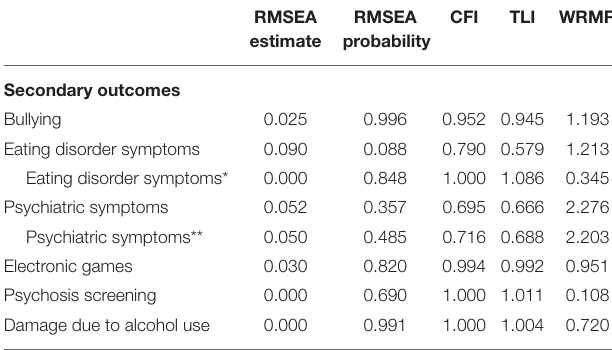
TABLE 3 | Internal agreement level according to the Kappa index for the primary outcomes of drug use by public-school students from the city of São Paulo paired in the segments 1 and 2 of the #Tamojunto2.0 drug prevention program evaluation questionnaire ( N = 207).